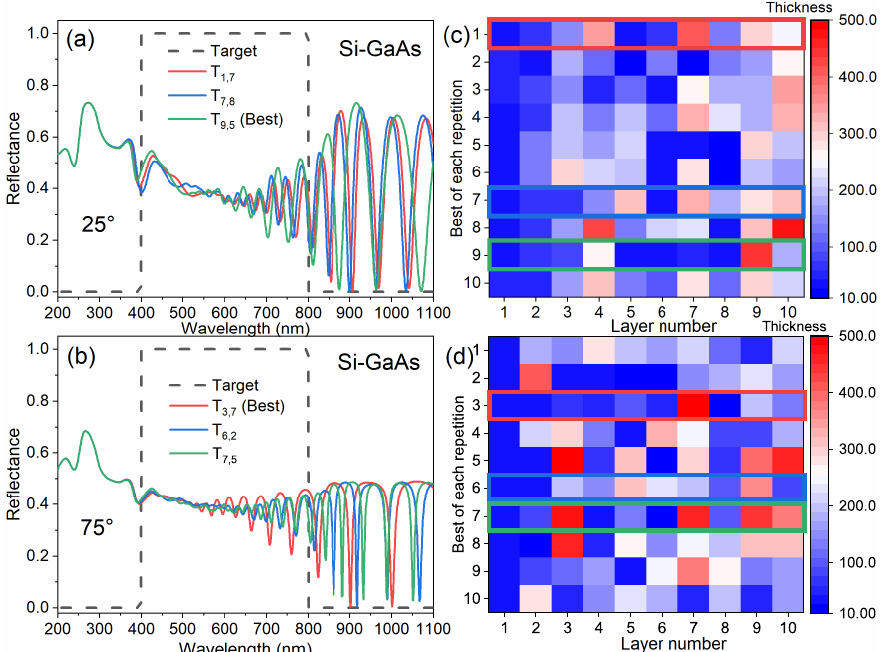
Figure 5. Reflectance spectra for Si-GaAs system at ( a ) 25 ◦ and ( b ) 75 ◦ of incidence compared to the target reflectance (dashed lines) for non-polarized light (color lines). ( c , d ) Chromosomal representation of the solutions. In this representation, it can be noticed that the configuration of layers is not ordered.